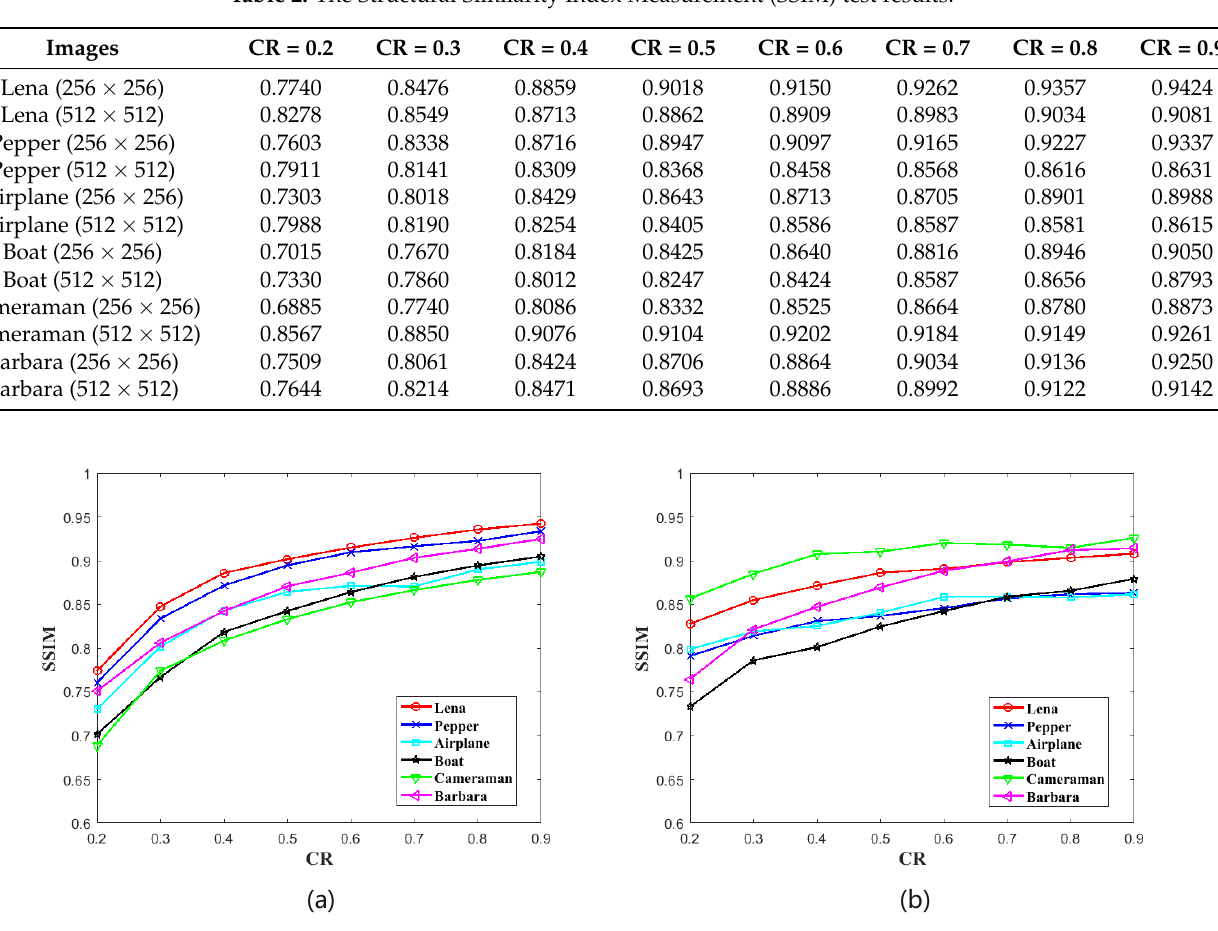
Figure 5. The Structural Similarity Index Measurement (SSIM) test result. ( a ) is shown the results of images with the size of 256 × 256. ( b ) is shown the results of images with the size of 512 ×